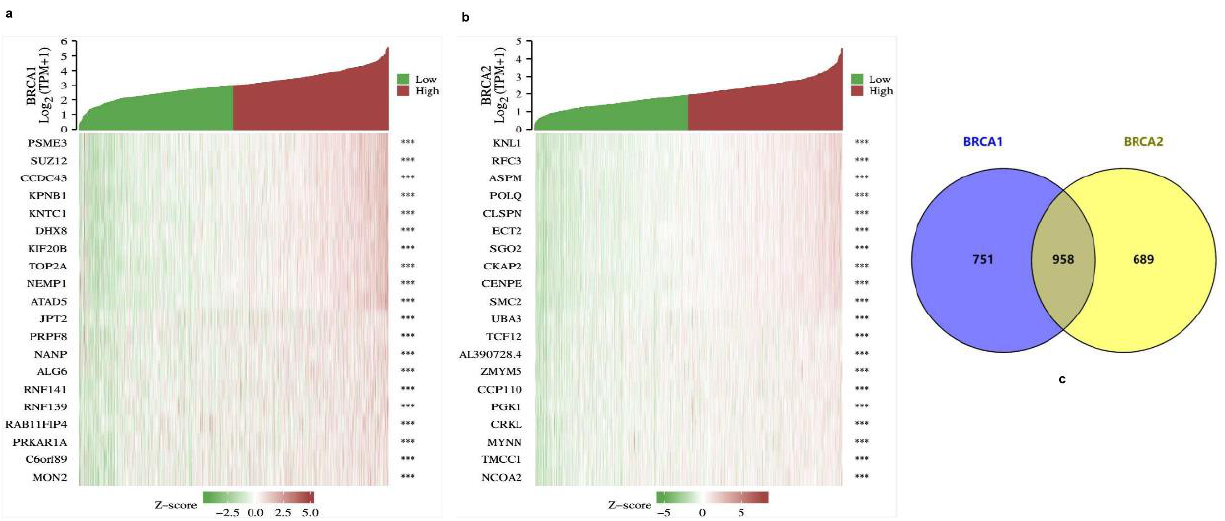
Figure 6. Co-expressed genes of BRCA1/2 . ( a , b ) The top 10 genes with positive and negative co- expression of BRCA1/2 in the TCGA database according to heat map and Venn map. ( c ) Intersection co-expression genes of BRCA1/2 . Note: |r| > 0.4 and p < 0.001.